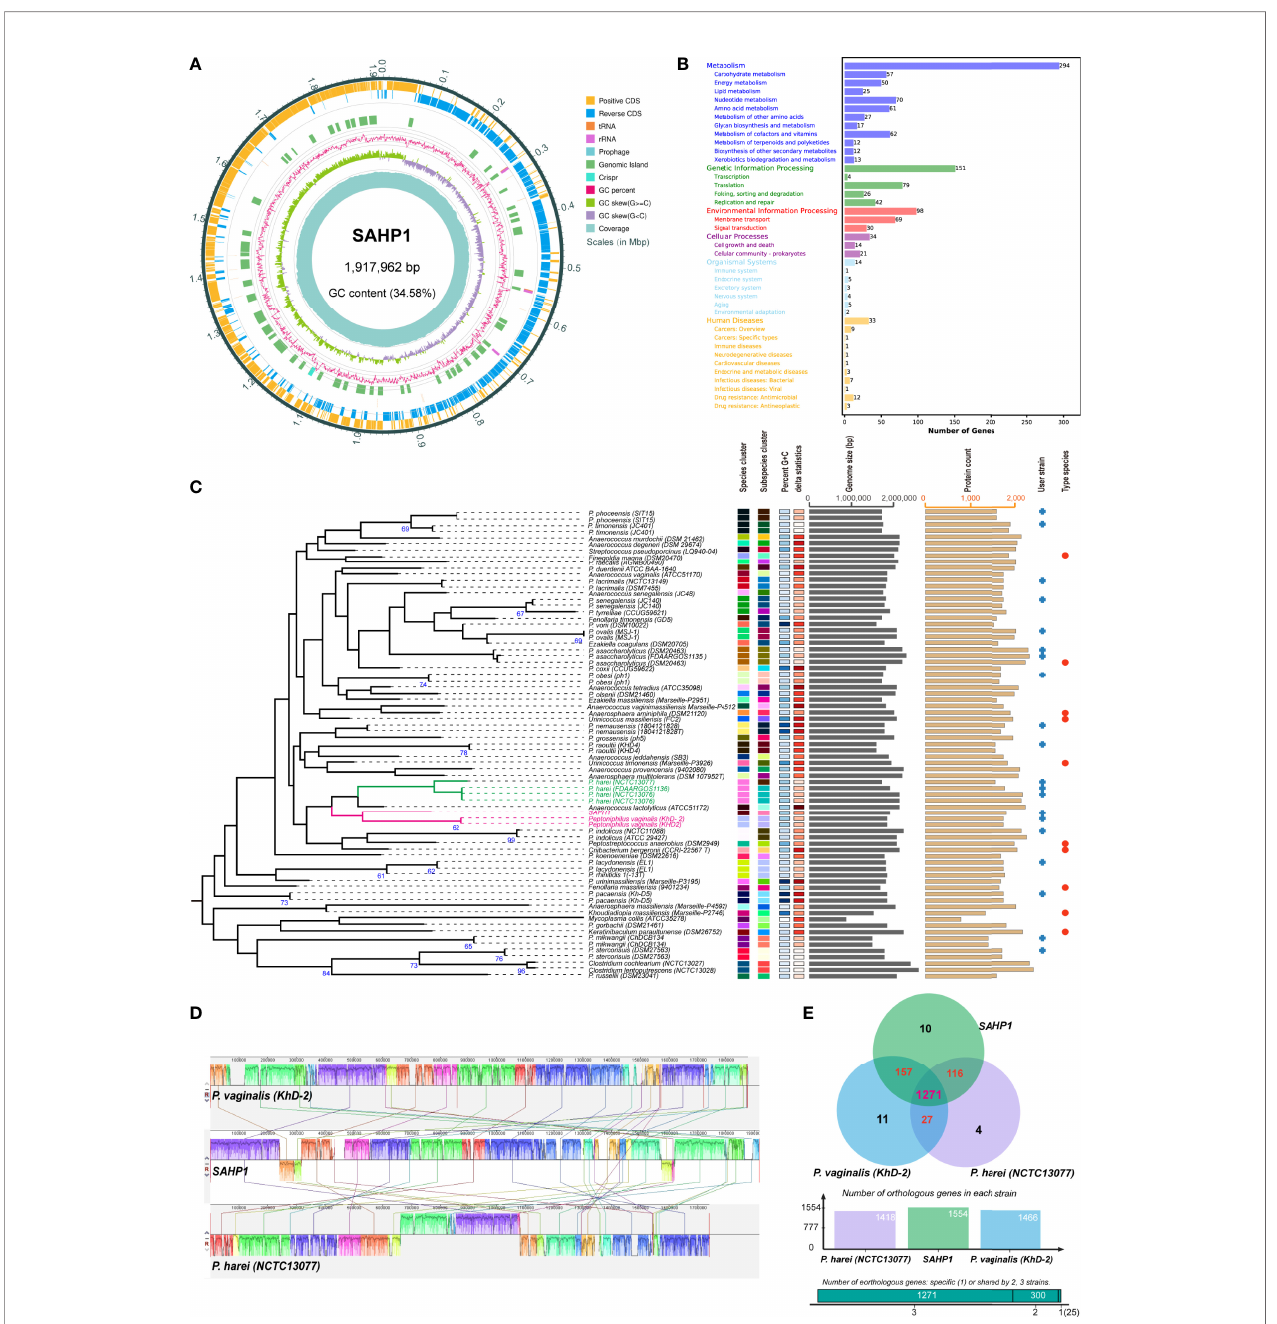
FIGURE 5 | Genomic features of SAHP1 and comparative genomic analysis. (A) Graphical circular map of P. septimus strain SAHP1 genome. (B) Functional categorization of SAHP1 protein-coding genes based on the KEGG. (C) The GBDP tree of SAHP1 and other related strains using the genome data from the NCBI database (user strain) and those automatically implemented by the TYGS database. The tree was inferred with FastME 2.1.6.1 from GBDP distances calculated from genome sequences. The branch lengths are scaled in terms of GBDP distance formula d 5 . The numbers above the branches are GBDP pseudo-bootstrap support values >60% from 100 replications, with an average branch support of 29.8%. (D) Genome-to-genome alignment of P. septimus strain SAHP1, P. vaginalis strain KhD-2, and P. harei strain NCTC13077 using a progressive mauve software and P. septimus strain SAHP1 as the reference genome. Boxes with the same color indicate the syntenic regions. Boxes below the horizontal line indicate inverted regions. The colored locally collinear blocks (LCBs) show the conserved and highly similar genomic regions. The white areas inside the colored regions indicate sequence elements speci fi c to one genome that are not aligned. The height of the similarity pro fi le is present inside each block. The colored lines that connect LCBs represent translocations of homologous regions. Blocks above or below the horizontal bar indicate regions that aligned in the forward or reverse orientation, respectively. Rearrangements are shown by colored lines. (E) Venn diagram showing the number of orthologous protein-coding genes shared and unique between the three strains SAHP1, KhD-2, and